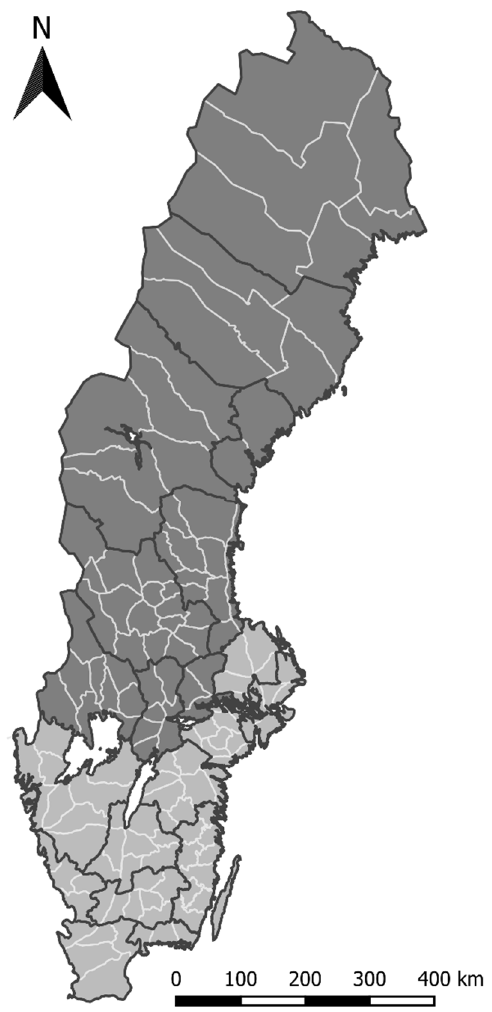
Figure 2. Distribution of moose management areas (MMAs; white boundaries; n = 144) in Sweden. The two different grey tones illustrate the separation of MMAs into the northern (dark grey, n = 68) and southern (light grey, n = 76) groups according to the border of the boreal and nemoboreal vegetation zones [61]. Administrative groupings of MMAs (i.e., administration per county) are illustrated with black boundaries.